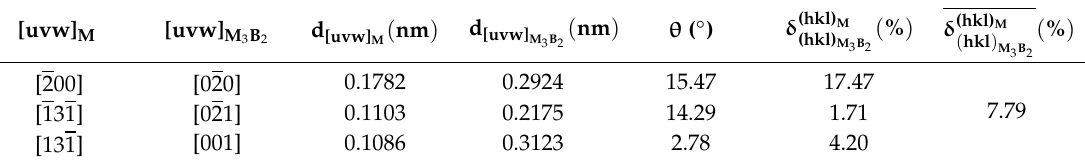
Figure 6. TEM micrographs ( a ) and corresponding selected area electron diffraction (SAED) patterns of phase interface ( b ) of the matrix (M- γ + γ′ ) and M 3 B 2 borides in the specimen brazed for 30 min. Table 3. Matching degree factor of the phase interface between matrix and M 3 B 2 borides.